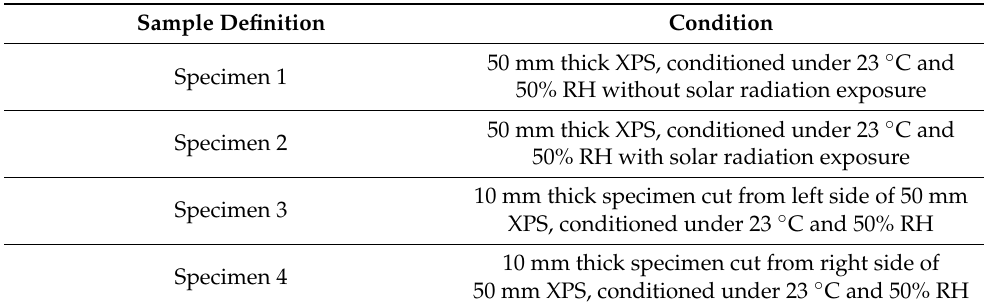
Table 1. Sample definitions and preparation